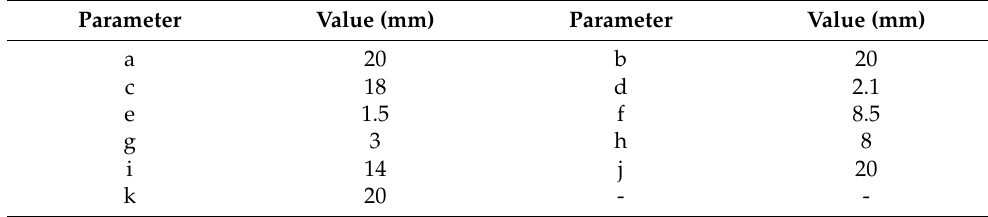
Table 1. The optimized parameters of the final proposed